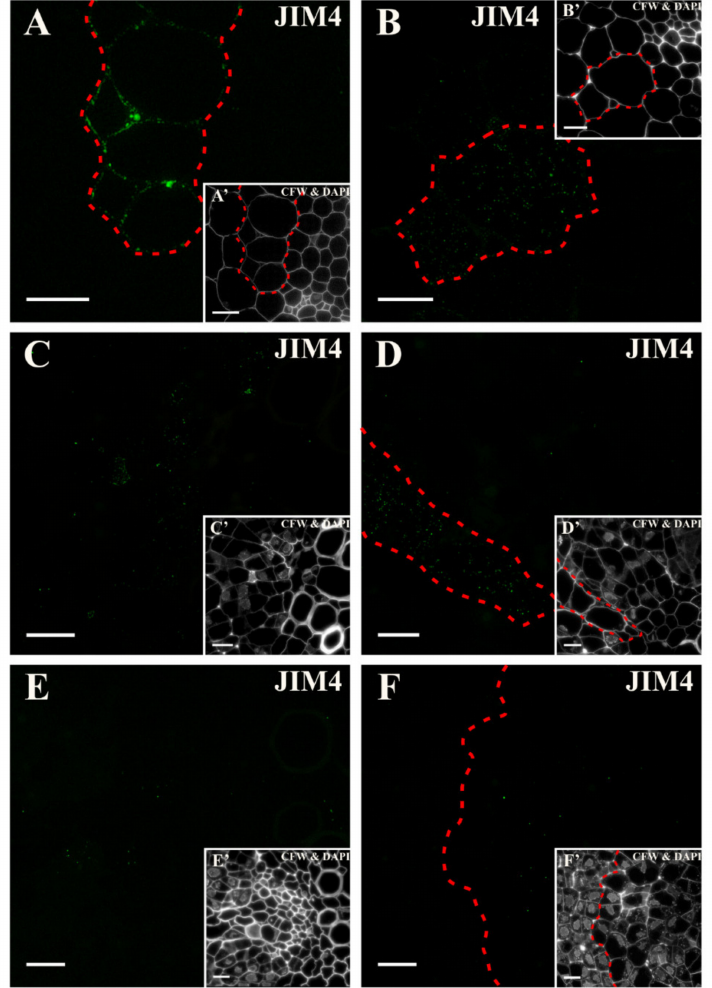
Figure 6. Distribution of the arabinogalactan protein (AGP) epitope that is detected by the JIM4 antibody at di ff erent time points of the culture. ( A ) At the beginning, the signal was present in the pericycle cell walls that were located on the xylem side (area marked with dashed line). ( B ) After two days, only a punctate signal was detected in the cytoplasmic compartments of the pericycle cells (area marked with dashed line). ( C ) From the fourth day, a punctate signal in the cytoplasmic compartments of some explant cells was detected. ( D ) On the next day, a punctate signal inside some of the highly vacuolated cells was present (area marked with dashed line). ( E , F ) Signal disappearance in the following days of the culture was noticed ( E —10 days; F —18 days). ( A’ – F’ ) Calcofluor white (CFW) and DAPI staining of the section shown on A – F . Scale bars: A – F , A’ – F’ —10 µ